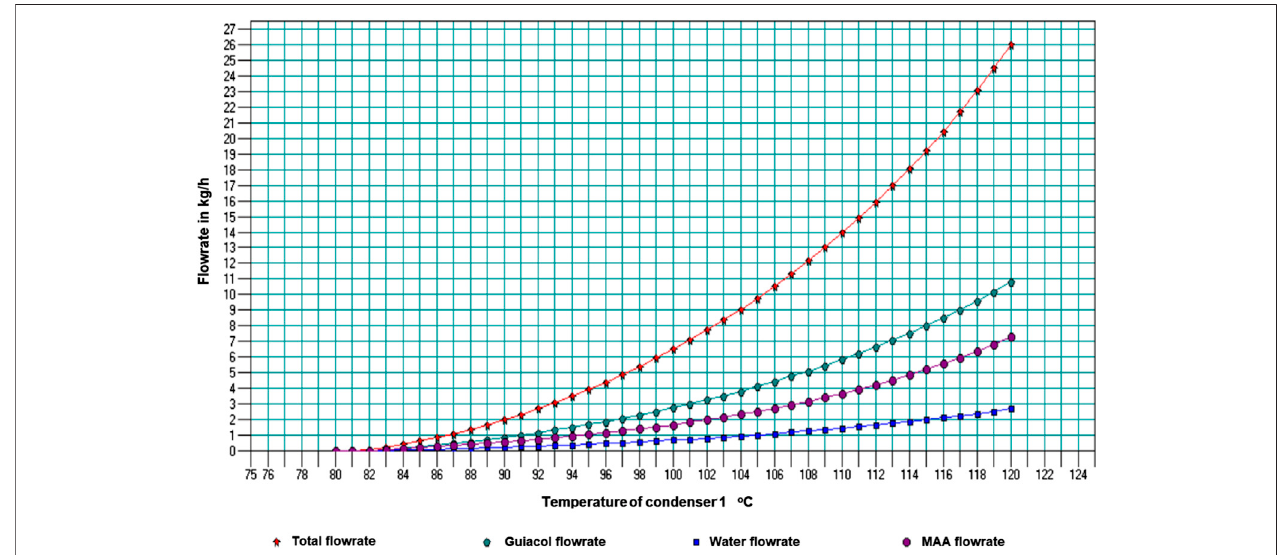
FIGURE 5 | Stream yield and composition from the secondary condenser with variation of the primary condenser temperature.